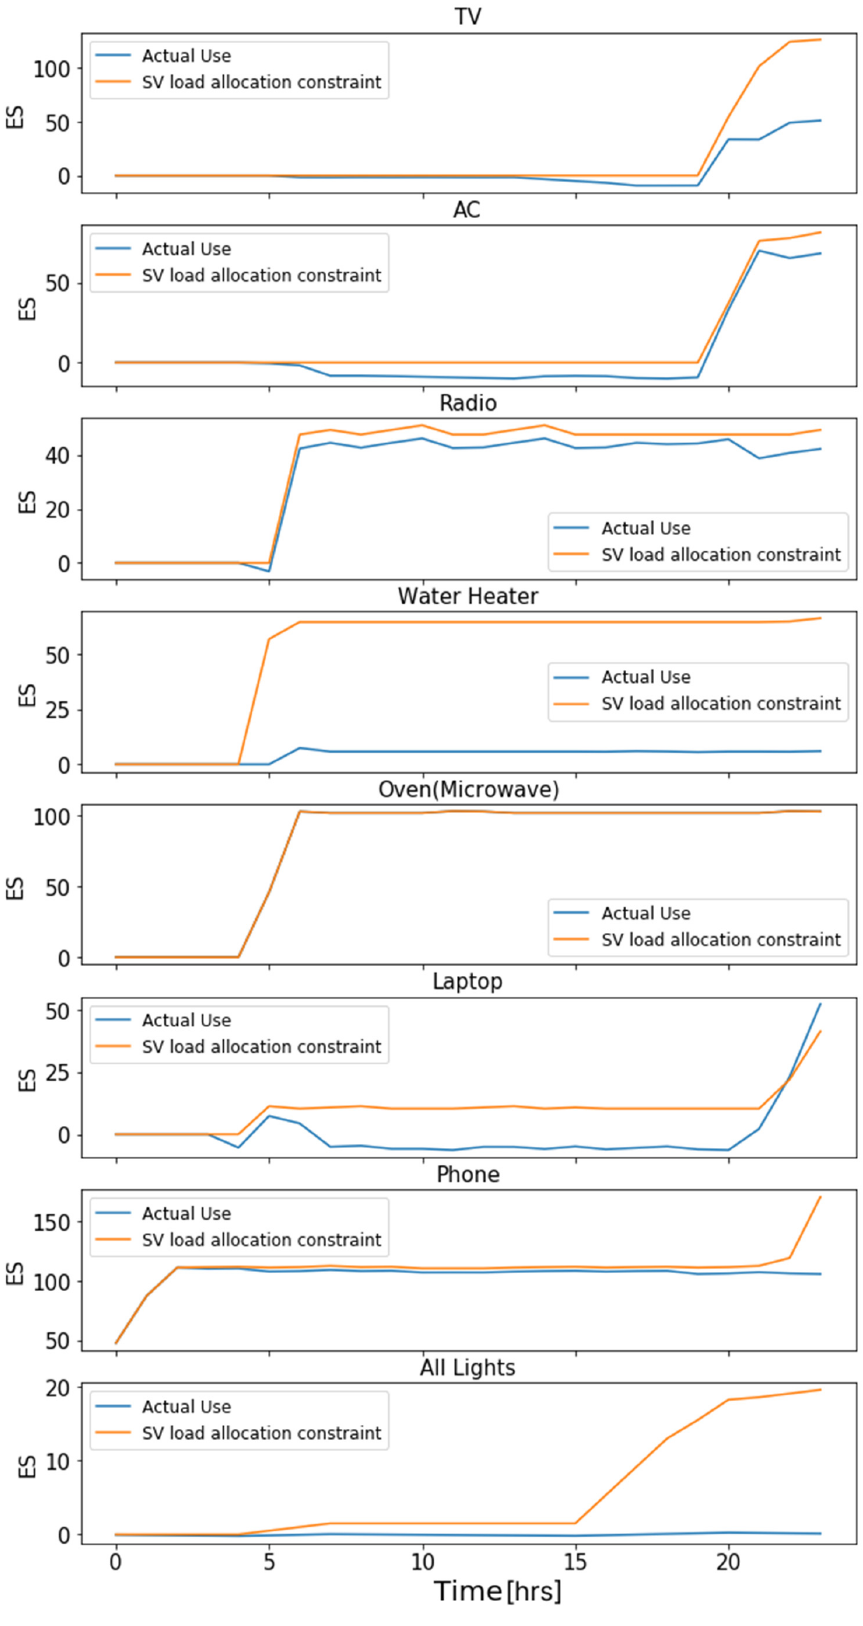
Figure 10. ES derived from each device with the proposed SV load allocation algorithm vs. real usage according to the REDD [31] database.